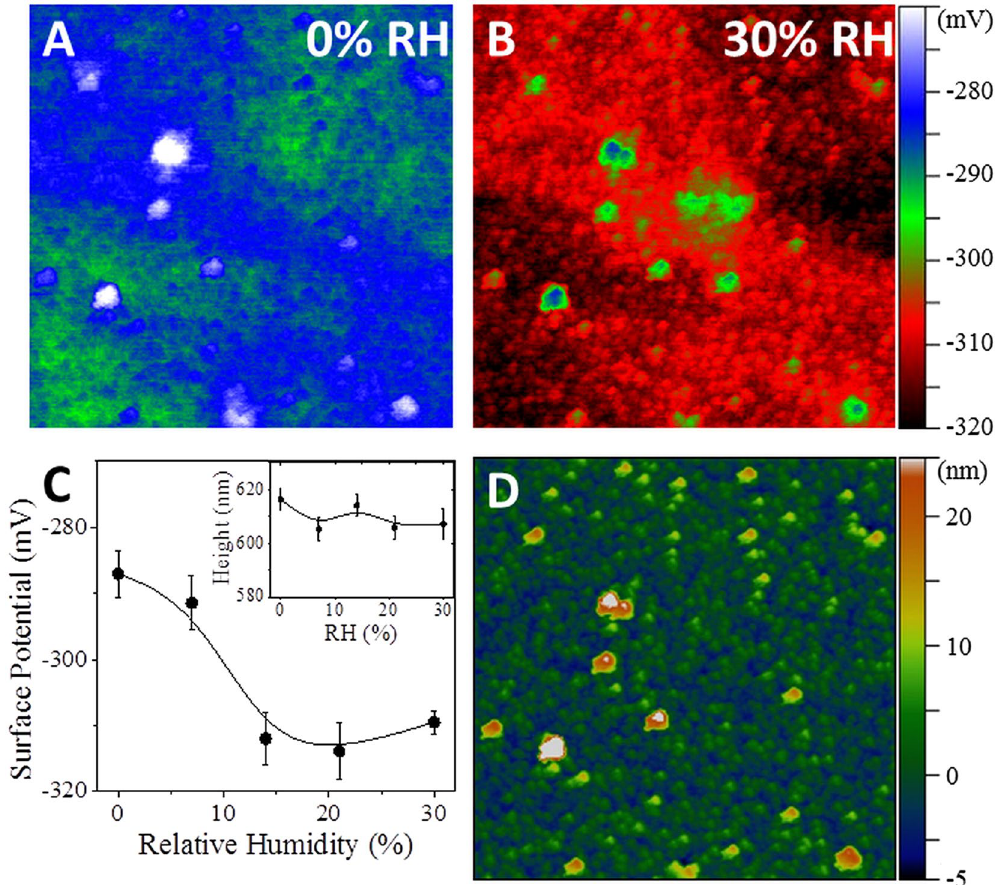
Figure 6. False color coded KPFM surface potential maps of a ZnO film on a polyimide substrate in a RH controlled Ar atmosphere at 0% RH ( A ) and 30% RH ( B ). Large aggregates are detached from the conductive network of crystallites, and thus do not show as much change in surface potential. Comparison of the averaged surface potential at each water concentration ( C ) shows the surface potential becoming increasingly negative with increasing humidity, which is expected from a reaction between water and the ZnO surface. Evidence of saturation above 14% likely corresponds with the formation of a water monolayer. No changes in the average AFM height ( C , inset) to RH show that the measured surface potential response is not an artifact related to changes in film thickness. The topography of the ZnO surface is shown for reference ( D